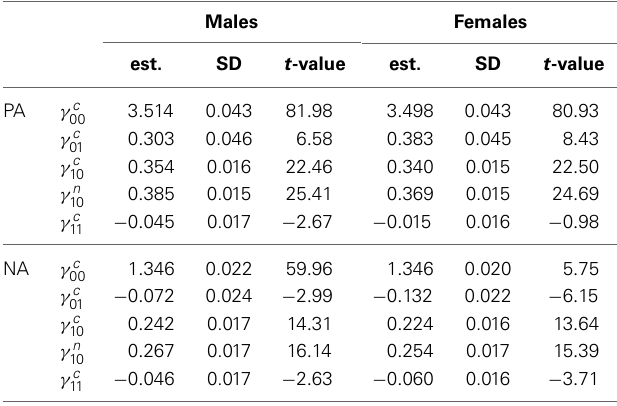
Table 6 | Results for multilevel autoregressive model with a level 2 predictor (with random effects). Males